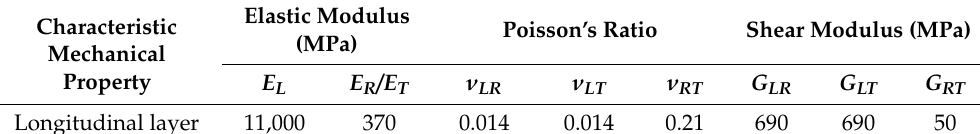
Table 3. Mechanical properties used in FE models for validation against experimental results.